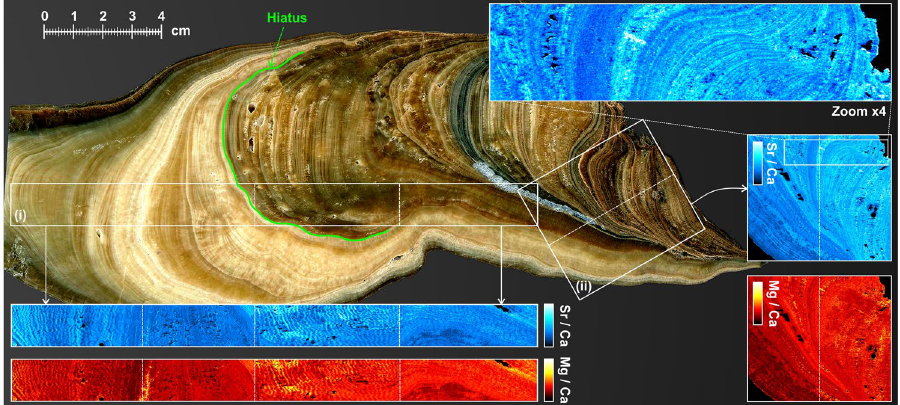
Figure 3. Speleothem imaging. Measurement (i): 15- µ m resolution images of Sr (blue) and Mg (red) assembled from 4 successive sequences (shown by dot lines). The total scanned length corresponds to more than 16 cm, and the probed surface to ~24 cm². This analysis represents approximately 12 000 000 individual measurements (i.e., pixels). Measurement (ii): 15- µ m resolution images of Sr and Mg for a ~5 × 4 cm sample surface. This analysis represents more than 9 000 000 pixels. A factor-of-four zoom is also shown for Sr. All the Sr and Mg images have been normalized by Ca. The green line indicates a major hiatal surface representing a time gap in calcite growth during speleothem